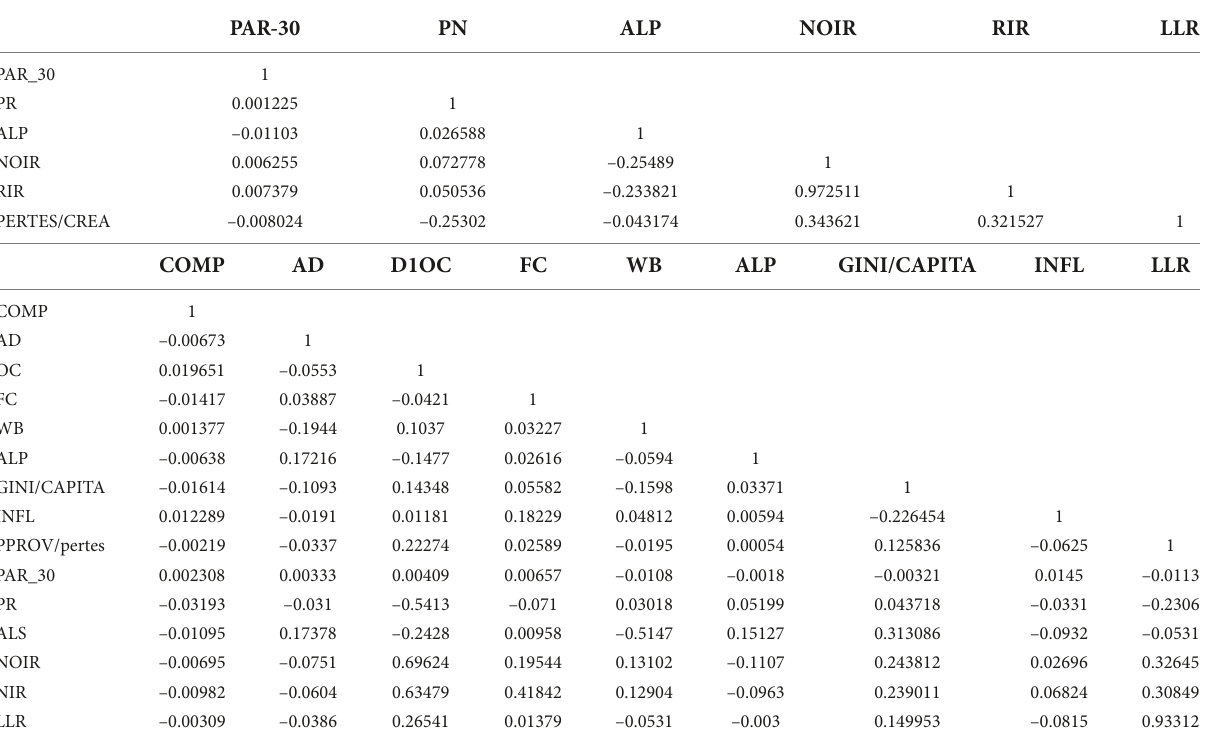
TABLE 5 Results of correlation coefficients.